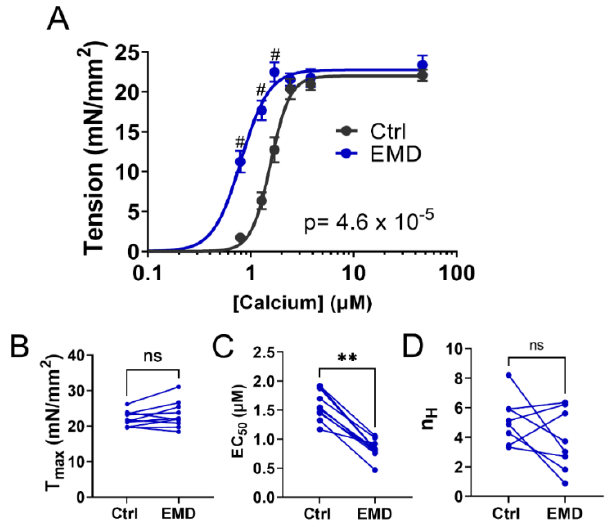
Figure 1. Permeabilized porcine myocardium mechanics with EMD treatment. ( A ) Active tension in a function of calcium concentration in the absence (black) and presence (blue) of 10 uM EMD (EMD). Tension under the maximally activated (T max ) condition ( B ), the concentration of calcium to achieve the half-maximal activation (EC 50) ( C ) and Hill coefficient (n H ) of the tension calcium relationship ( D ) before and after the EMD treatment. ns : not significant, ** p <0.01. # p < 0.000001.